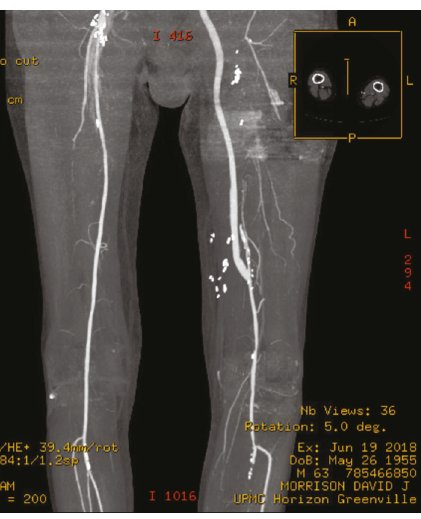
Figure 4: Postoperative CT angiogram of obturator bypass demonstrating distal anastomosis and runo ff